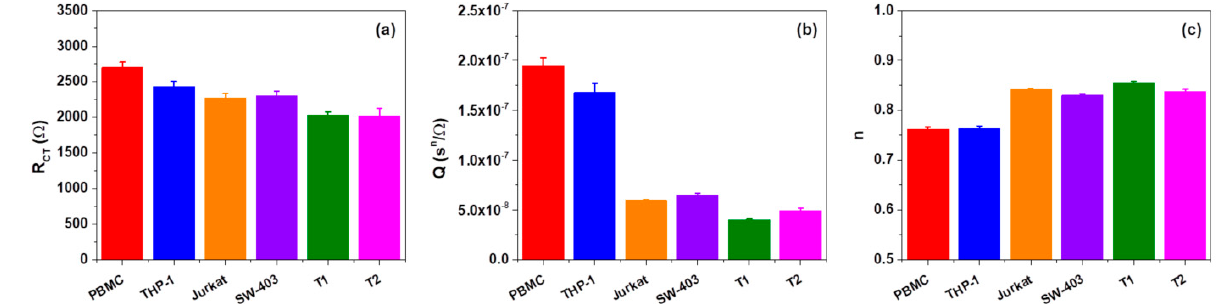
Figure 5. The electrical fitting parameters ( R CT ( a ), Q ( b ), and n ( c )) in the equivalent circuit model for studied cells. Error bars indicate the values of the relative estimated errors of the calculated parameters.